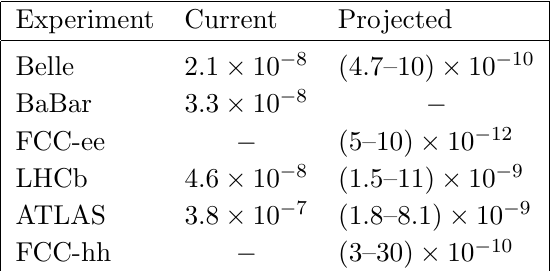
Table 1. Current and projected 90% C.L. limits on the (cid:28) current limits from the LHC experiments utilise only the 8 TeV data, while the projected limits are based on the complete 13 TeV data sets of 3 ab (cid:0) 1 for ATLAS and 50 fb (cid:0) 1 for LHCb from the high-luminosity run of the LHC.